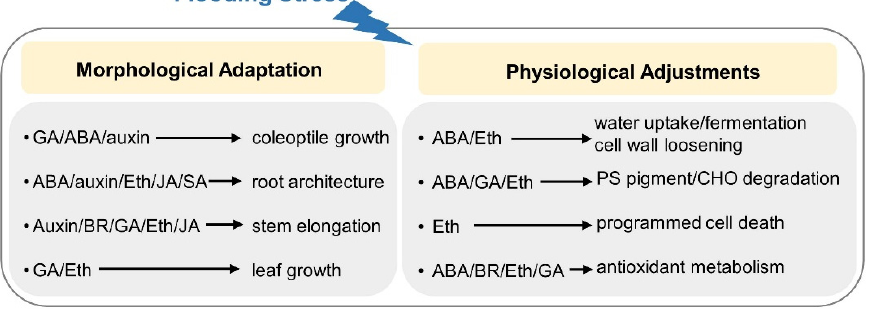
Figure 4. Summarizing overview of phytohormone-mediated morphophysiological alteration in flooded plants. Phytohormone-mediated morphological adaptation in flooded plants, including coleoptile growth, root architecture, stem elongation, and leaf petiole movement, is summarized. In addition, physiological adjustments induced by phytohormones under flooding are indicated, including water absorption, anaerobic respiration, cell wall loosening, photosynthetic pigment, carbohydrate degradation, programmed cell death, and antioxidant metabolism. ABA, abscisic acid; BR, brassinosteroid; CHO, carbohydrate; Eth, ethylene; GA, gibberellic acid; JA, jasmonic acid; SA, salicylic acid; PS, photosynthetic.